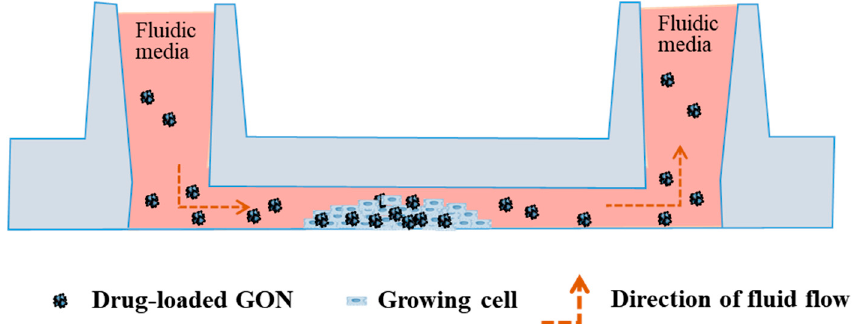
Figure 2. A cross-sectional view of a microfluidic cell chamber showing cellular behaviors of NPs under the biomimetic microfluidic system (BMS).